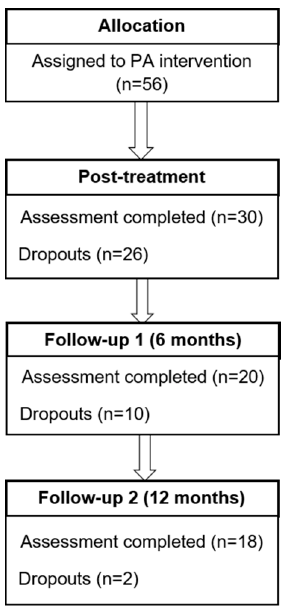
Figure 1. Patient flow diagram. PA: positive affect